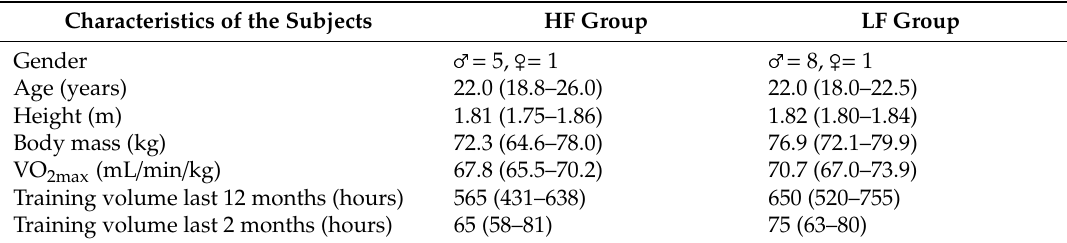
Table 1. Baseline characteristics of test subjects in the high-frequency group (HF group) performing four interval sessions per week, and in the low-frequency group (LF group) that performed two interval sessions per week. Values are presented as the median and inter quartile range (IQR). There were no significant di ff erences between the